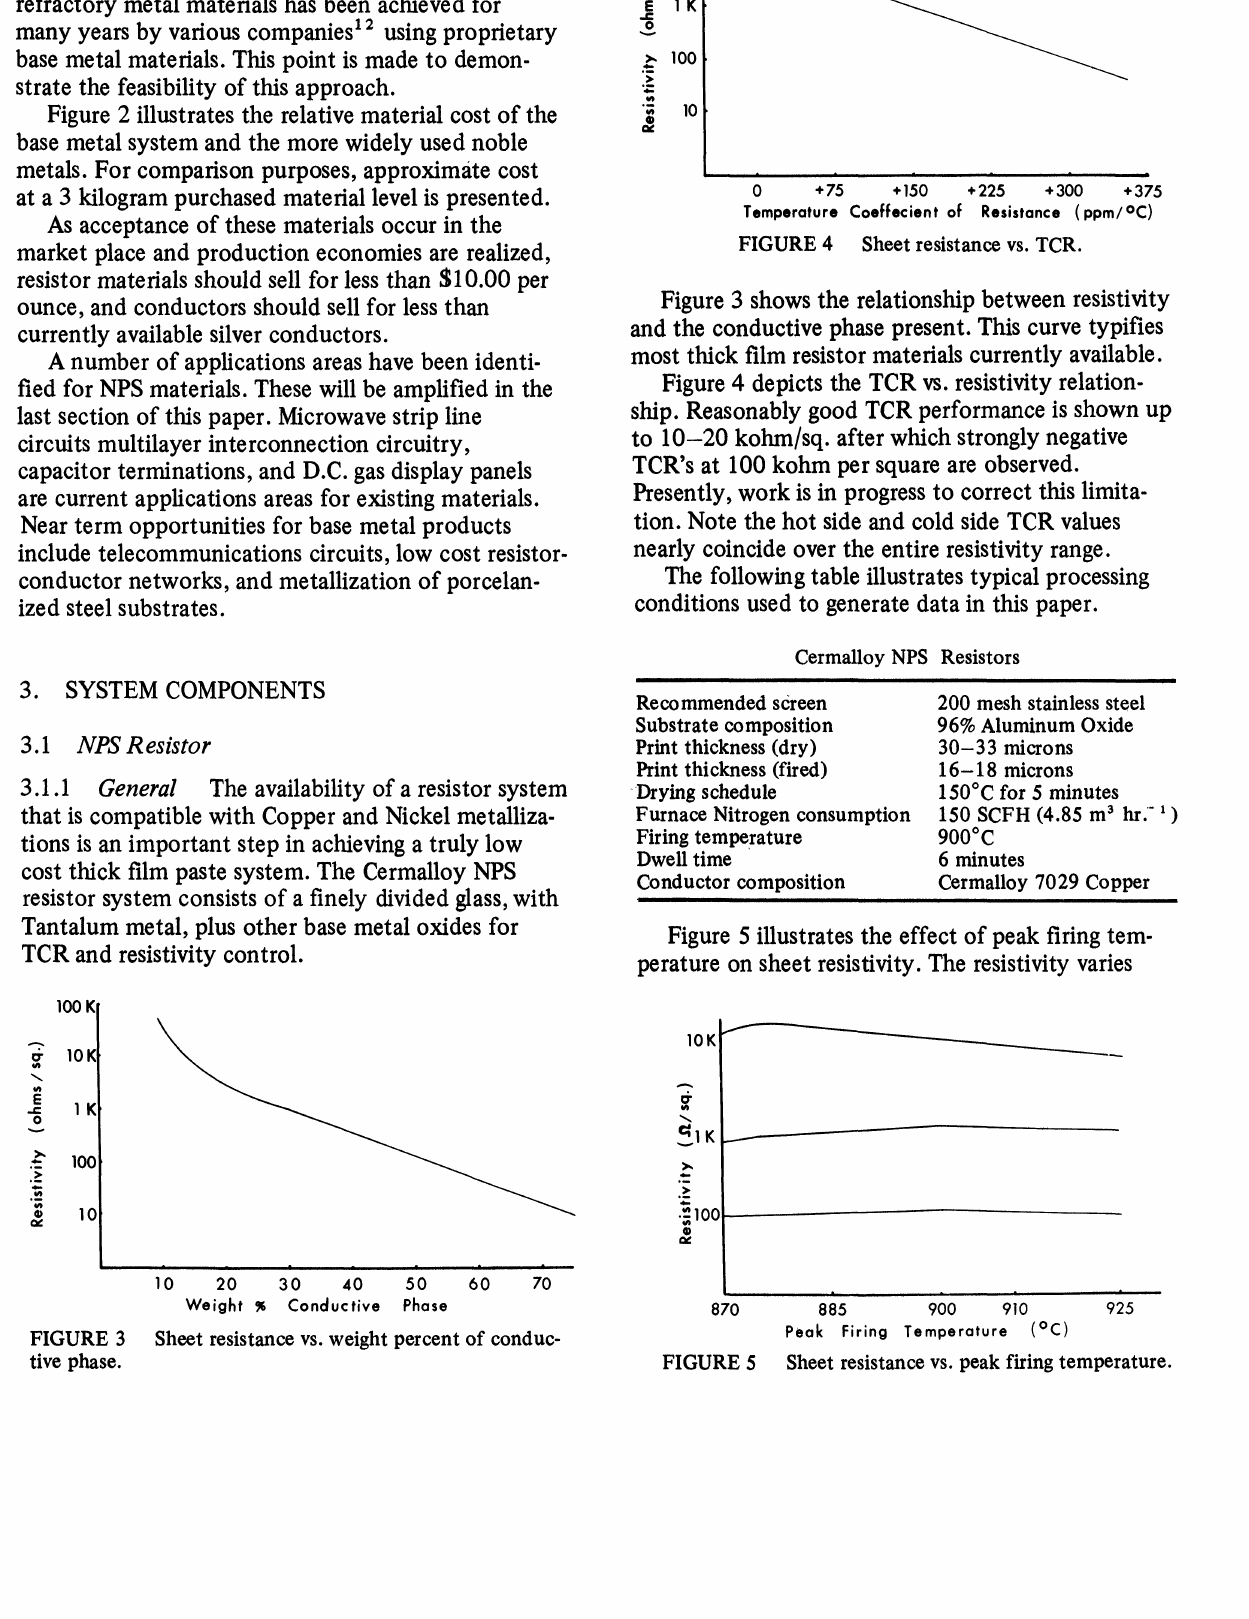
885 900 910 925 Peak Firing Temperature (C) FIGURE 5 Sheet resistance vs. peak firing